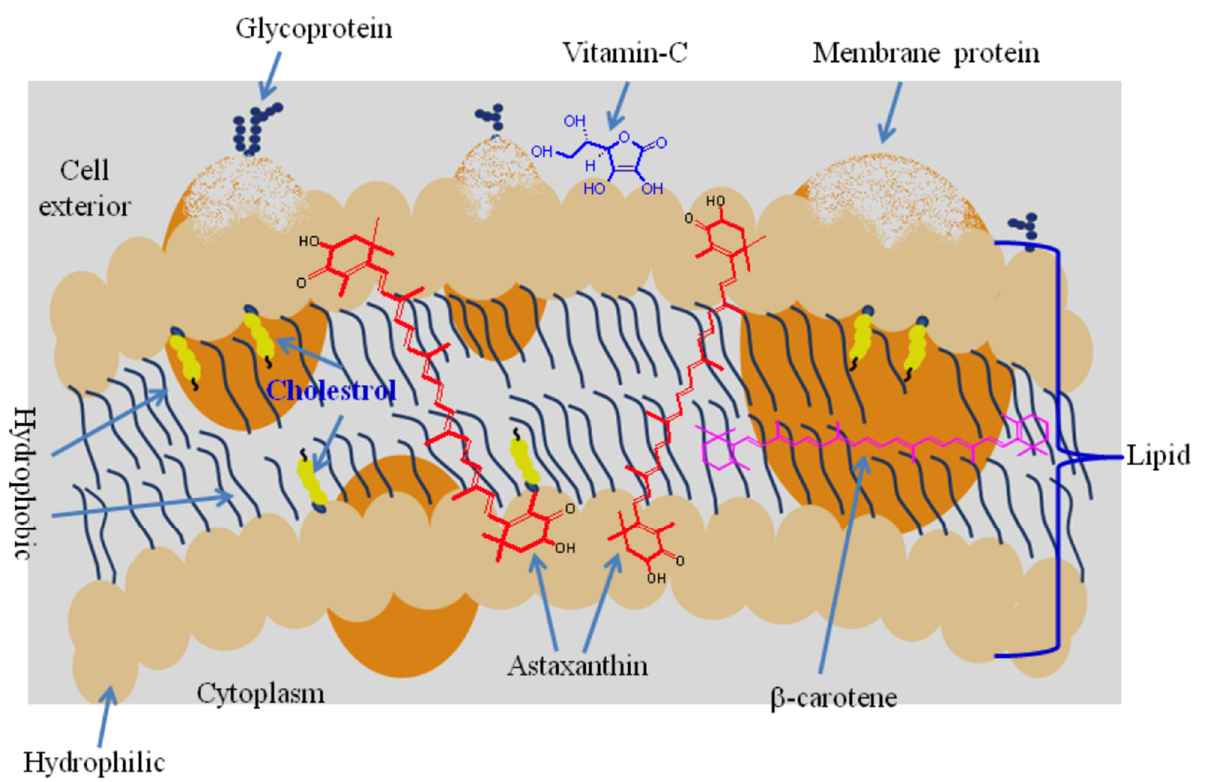
Figure 1. Position of astaxanthin in the cell membrane bilayer. (From: Ambati et al. [2].)